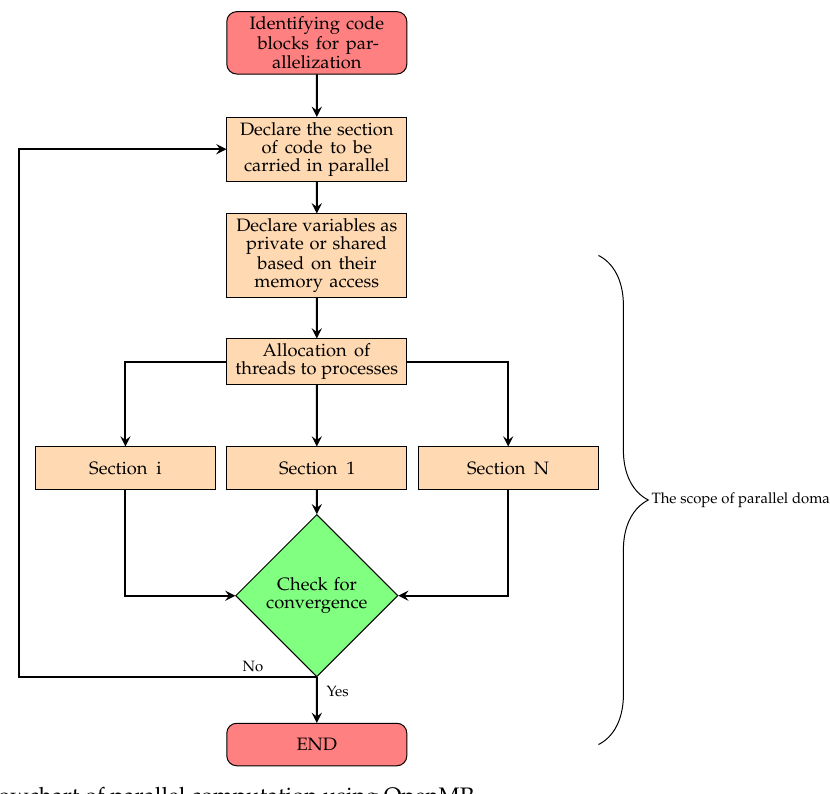
Figure 5. A flowchart of parallel computation using OpenMP.